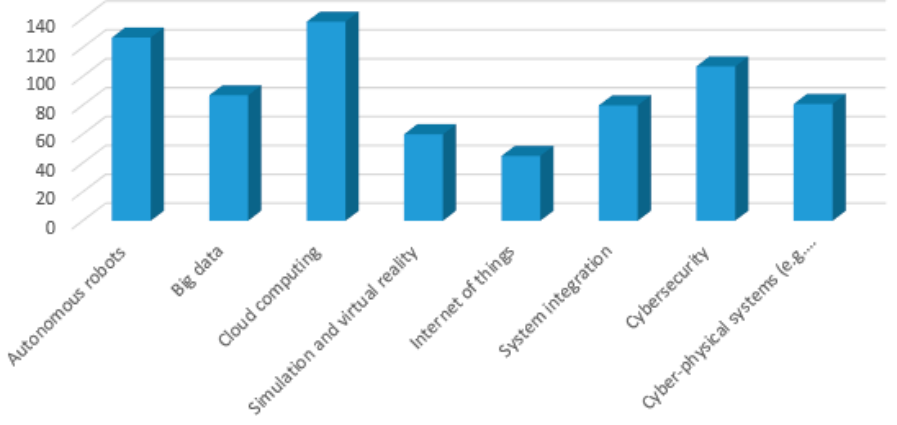
Figure 5. Introduced technologies of Industry 4.0.